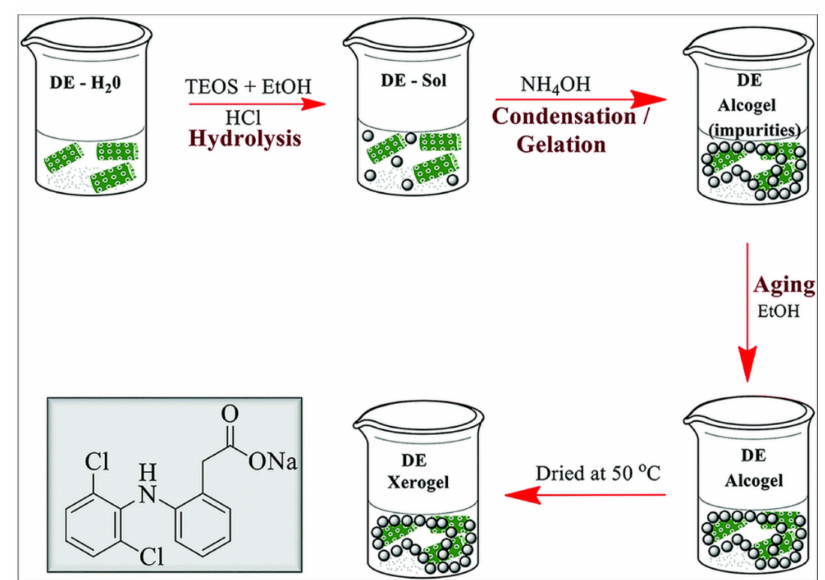
Figure 15. Schematic diagram showing DE-xerogel (DE-XER) synthesis. Inset: chemical structure of diclofenac sodium drug. Reproduced from [84] with permission from the Centre National de la Recherche Scientifique (CNRS) and The Royal Society of